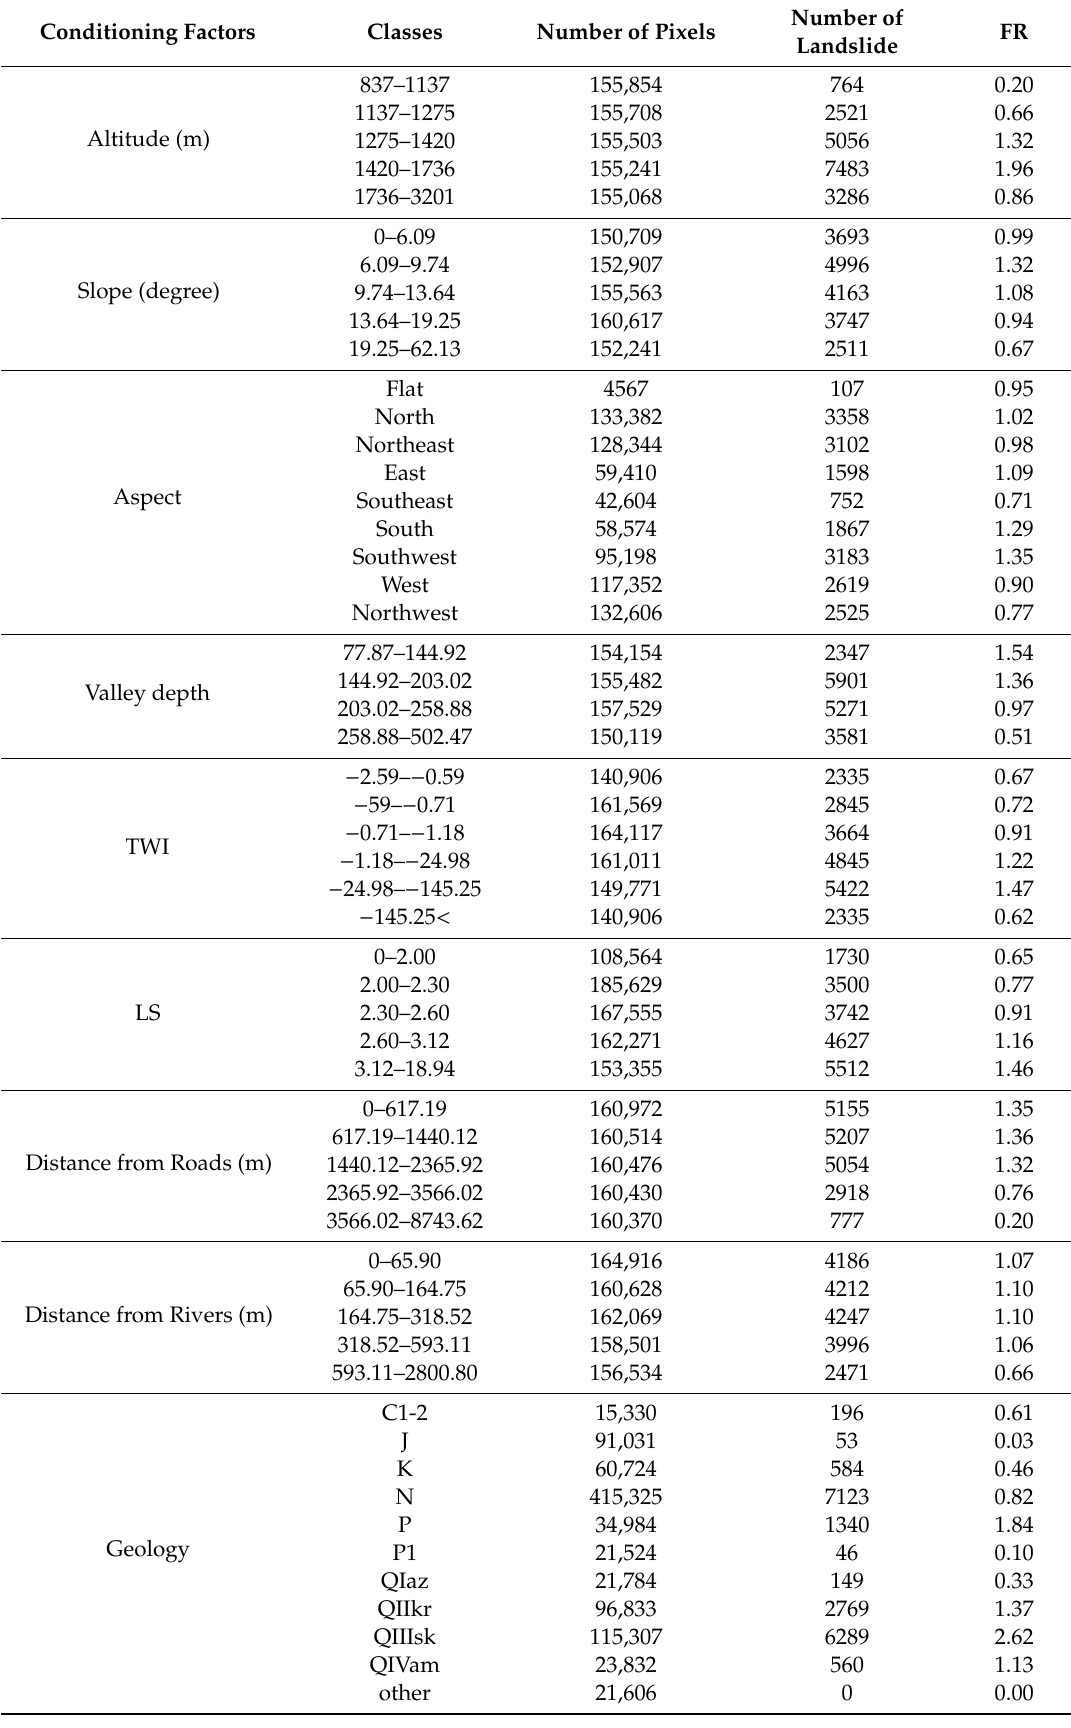
Table 3. Impact of conditioning factor subclasses on landslide probability using FR